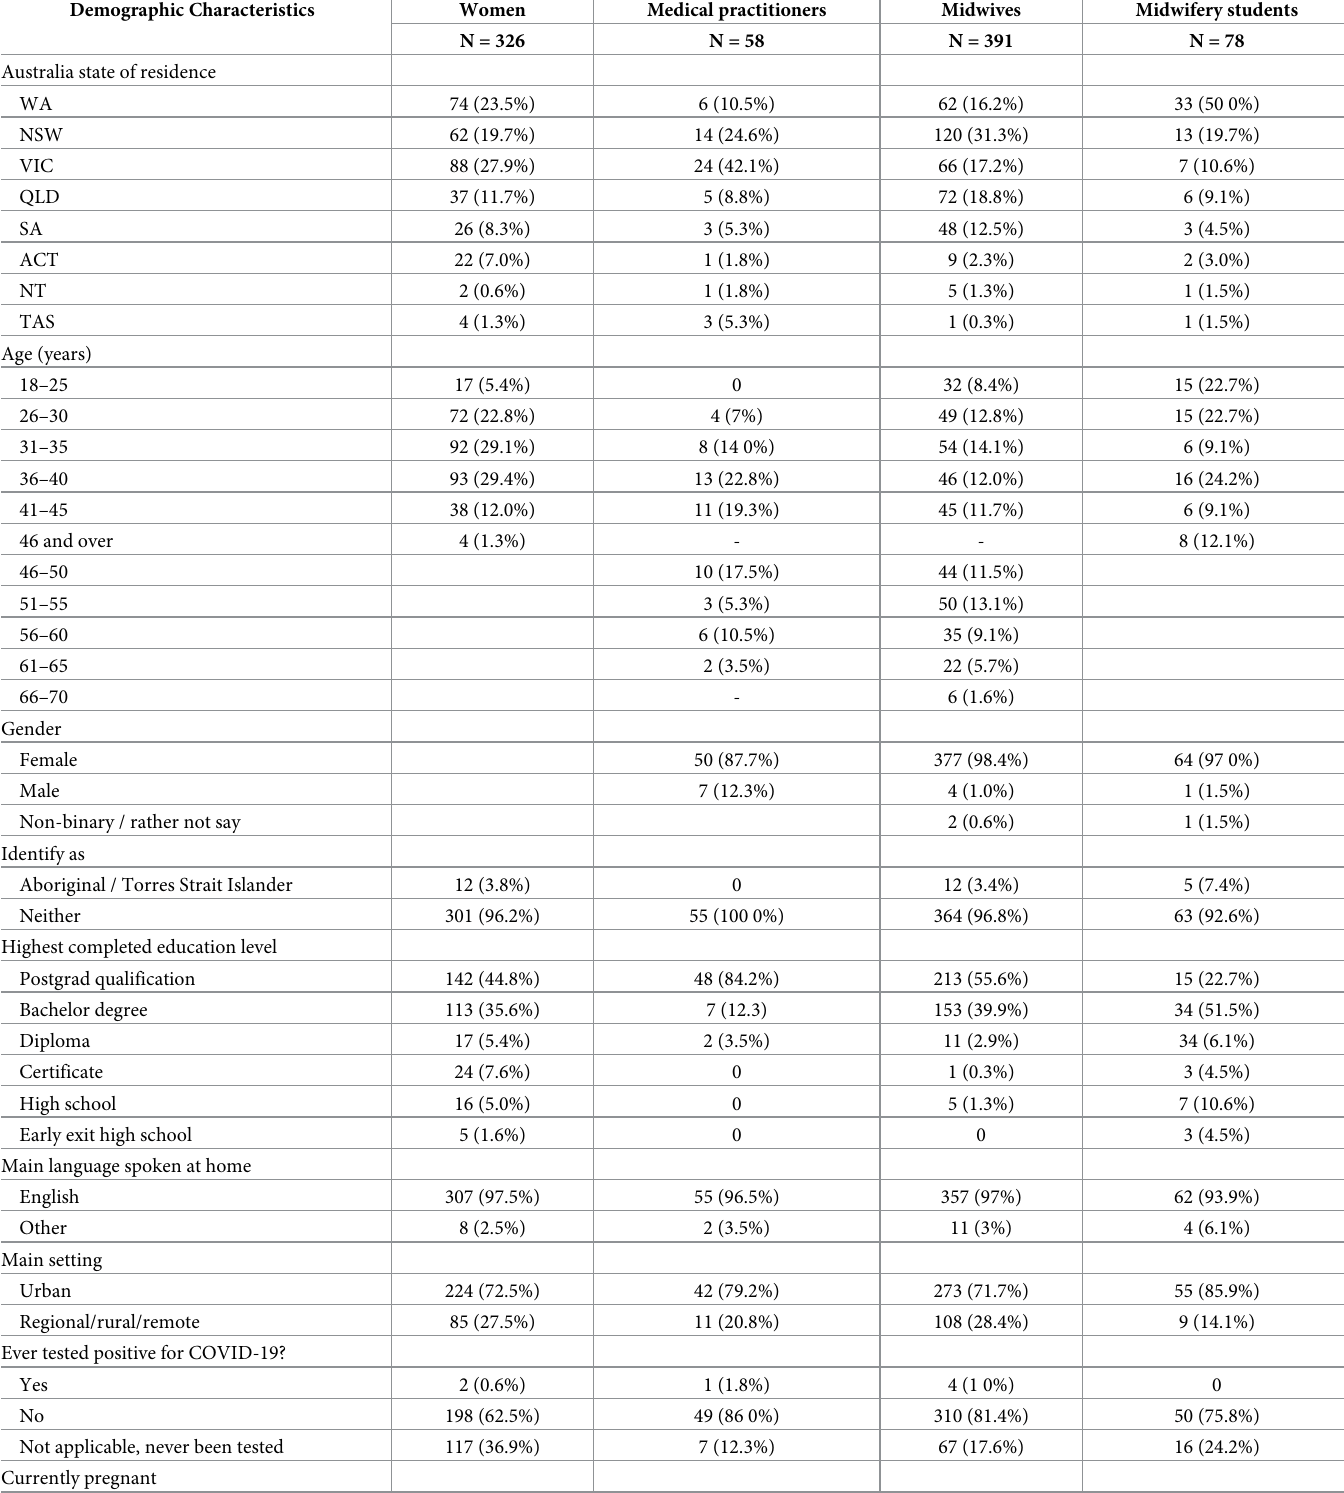
Table 2. Demographic characteristics of survey